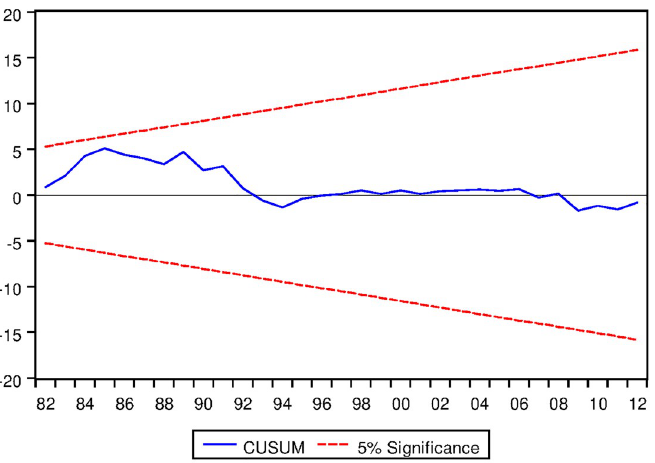
Fig 25. Stability diagnostic of cointegrating relationship for Australian data with no fixed regressor under Fisherian framework.